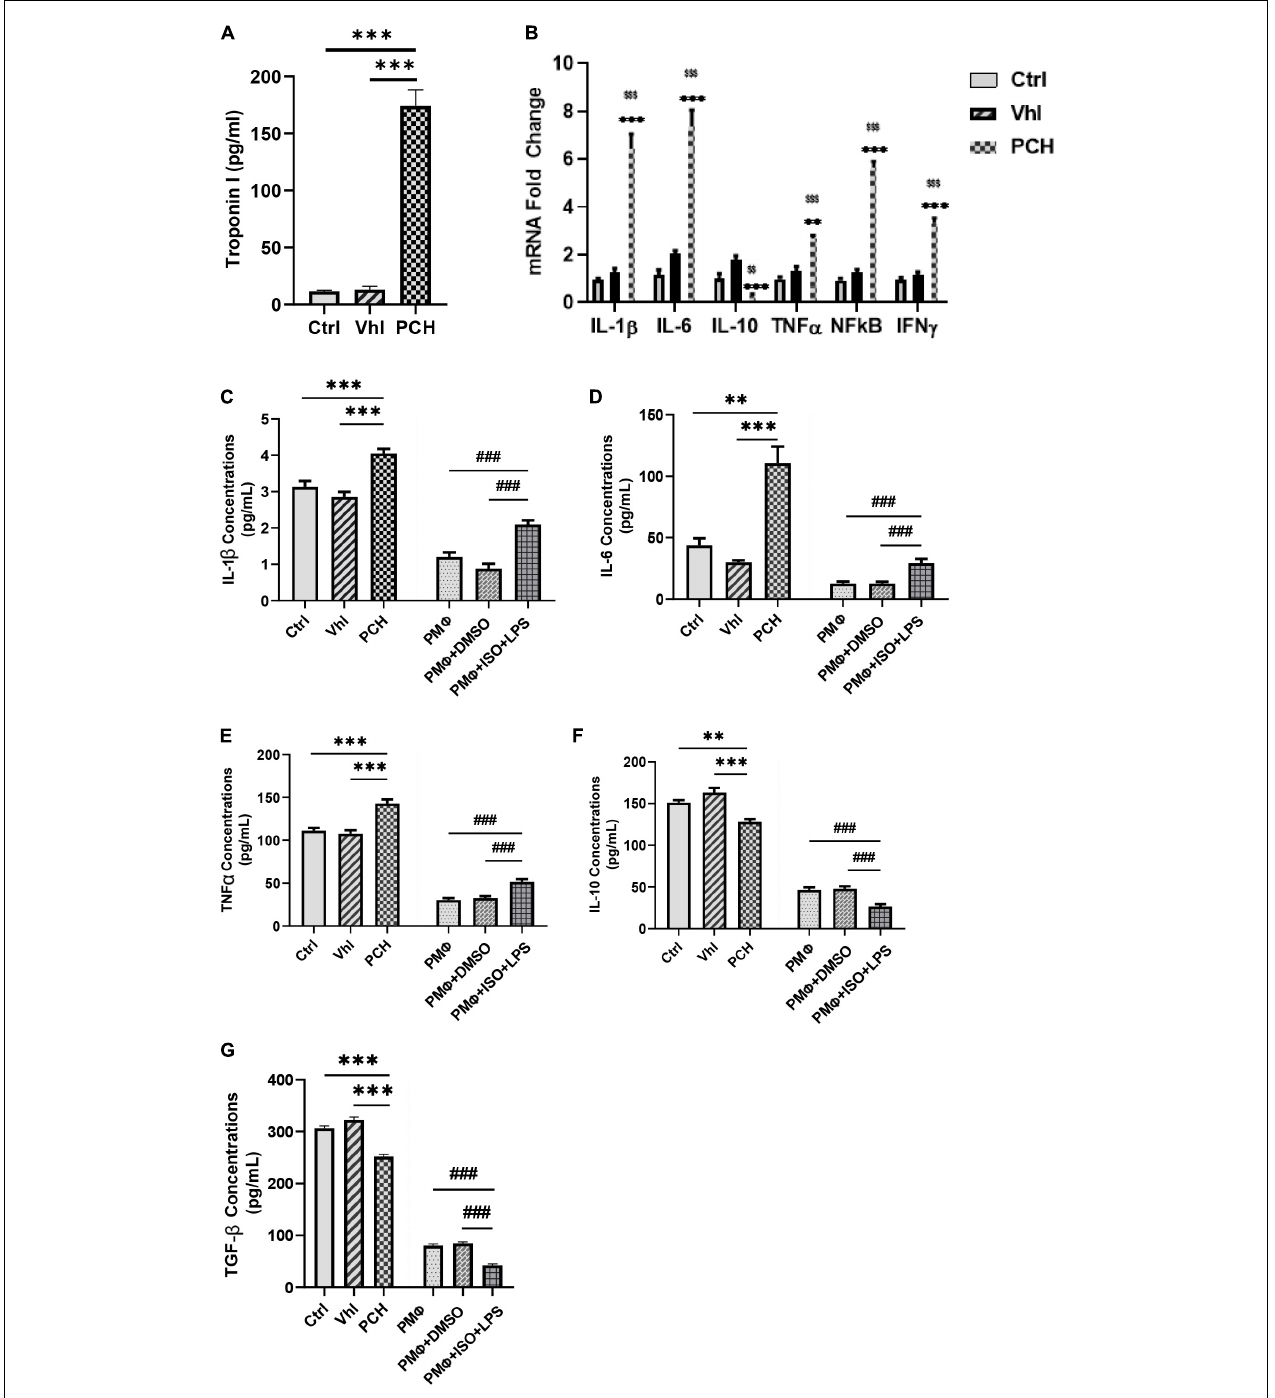
FIGURE 1 | Troponin from necrotic cardiomyocytes and lipopolysaccharides (LPS) elicits similar inflammatory responses during chronic catecholamine stress (CCS). (A) Sera concentrations of troponin I were evaluated by ELISA from Control (Ctrl), Vehicle (Vhl), and Pathological cardiac hypertrophy (PCH) groups. ∗∗∗ p < 0.001 (B) mRNA expressions of inflammatory markers (IL-1 β , IL-6, TNF α , IFN γ , and NF- κ B) assessed from the myocardial by qRT-PCR ( n = 6 hearts per treatment group). ∗∗ p < 0.01, ∗∗∗ p < 0.001 vs. Vhl; $$ p < 0.01, $$$ p < 0.001 vs. Ctrl. (C–G) Comparison with inflammatory cytokines secretion (IL-1 β , IL-6, TNF α , IL-10, and TGF- β ) between PCH mice ( in vivo ) and LPS-challenged peritoneal macrophages (PM φ ) ( in vitro ) during CCS. All ELISA evaluations were performed in triplicates ( n = 8 mice per treatment group). ∗∗ p < 0.01, ∗∗∗ p < 0.001 among in vivo groups; ### p < 0.001 among in vitro groups. Data are expressed as mean ± SEM. Data were analyzed using one-way ANOVA, followed by Tukey’s post hoc analysis. Abbreviations: IL, interleukin; TNFa, tumor necrosis factor-alpha; TGF- β , transforming growth factor-beta; IFNy, interferon-gamma.